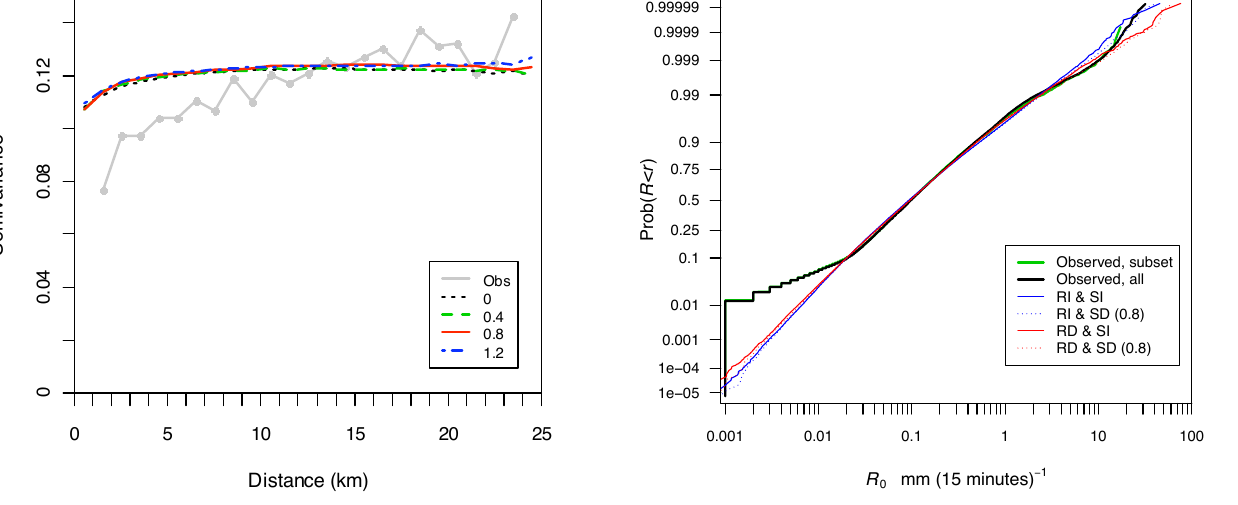
Fig. 7. Semivariogram of 15-min rainfall presence/absence from rain gauge data (heavy gray line and solid circles) and from sim- ulations (colored lines) using Models SI σ /RI σ /LN ( γ =0) and SD σ /RI σ /LN with γ =0.4, 0.8, and 1.2. process might remove this artifact; we return to this point briefly at the end of this section.